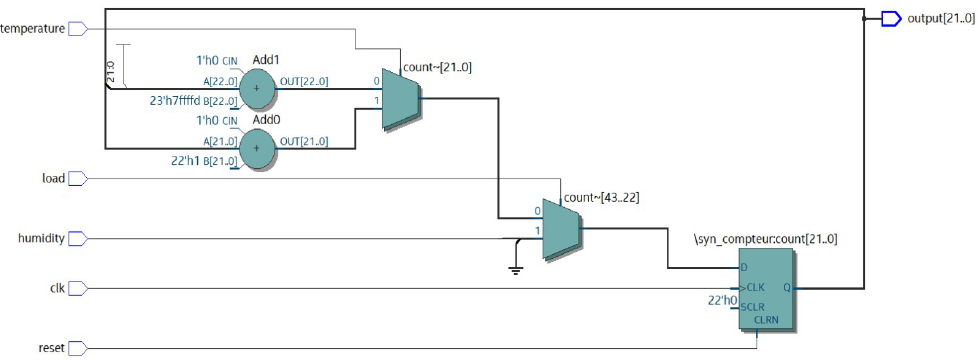
Figure 10. Structure of the smart monitoring system in Quartus Prime